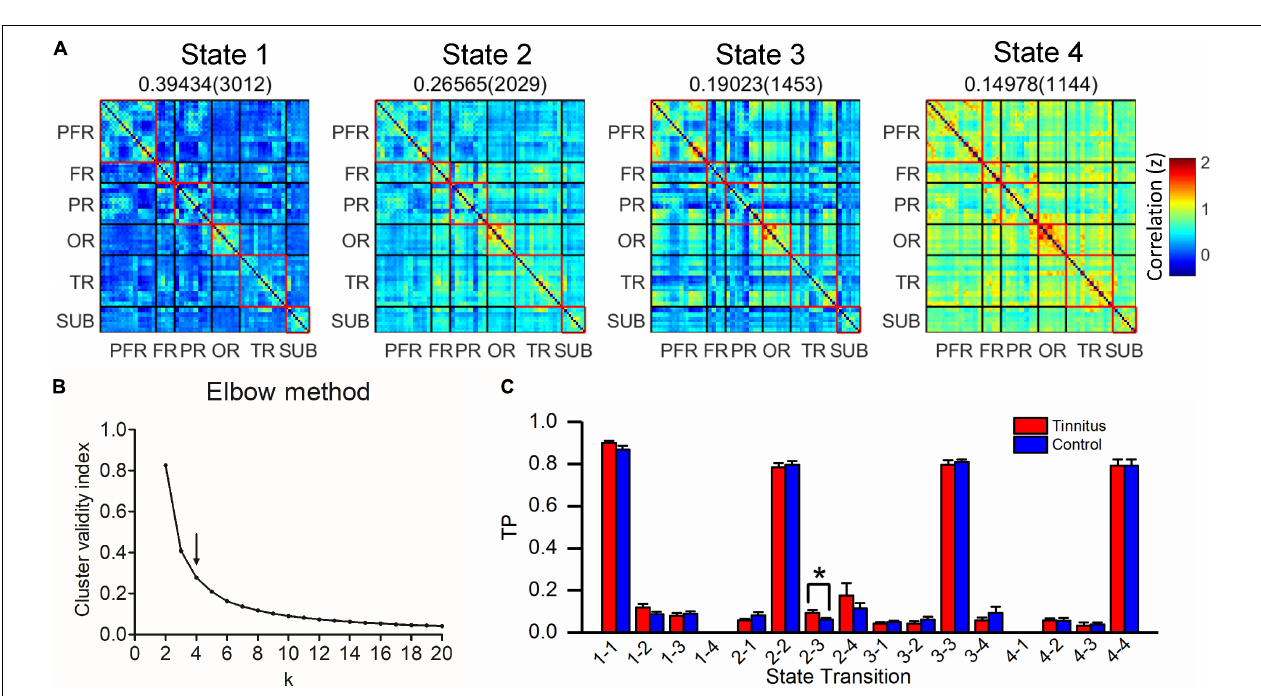
FIGURE 4 | Significant difference for DFC in chronic tinnitus patients before and after acupuncture. ANG, angular gyrus; DFC, dynamic functional connectivity; L, left; PCG, posterior cingulate gyrus; R, right.